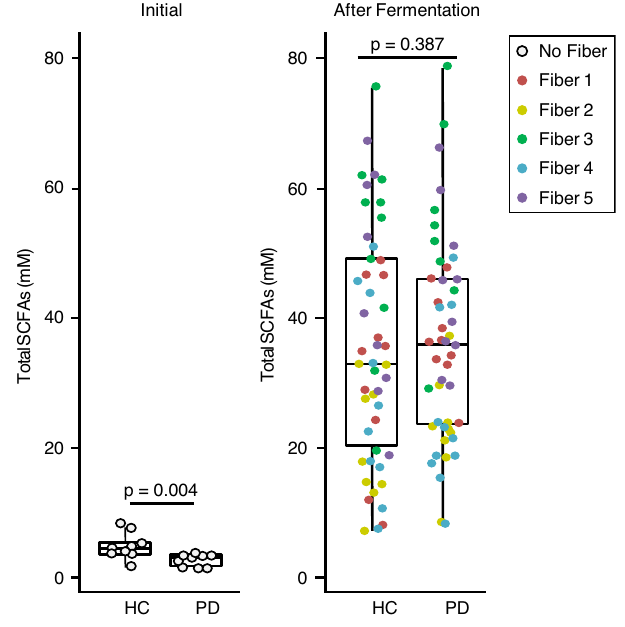
Fig.1|Fermentationofprebiotic fi berswithhumanstoolincreasesshort-chain fatty acid (SCFA) production. Stool obtained from PD patients had a lower con- centration of total SCFA than stool obtained from healthy controls (HC) (left panel, Student ’ s t test: P =0.004, n =10 biologically independent samples/group). Fer- mentation of stool with different fi bers (Fibers 1 – 5, 12h stool fermentation) increased total SCFA production in stool obtained from both HC and PD patients (right panel, Student ’ s t test: P =0.387, n =10 biologically independent samples/ fi ber/group). Fiber 1: fructooligosaccharides (FOS), Fiber 2: glucan, Fiber 3: pectin, Fiber 4: sorghum arabinoxylan and Fiber 5: a mixture of 25% of each of FOS, glucan, pectin,sorghumarabinoxylan.Foreachbox-and-whiskerplot,thecentralhorizontal line indicates the median, the bottom and top of edges of the box indicate the 25th and 75th percentiles (respectively), and the top and bottom whiskers indicate the 10th and 90th percentiles (respectively). Each point represents a biologically inde- pendent sample. A two-tailed Student ’ s t test was used for analysis. Source data are provided as a Source Data